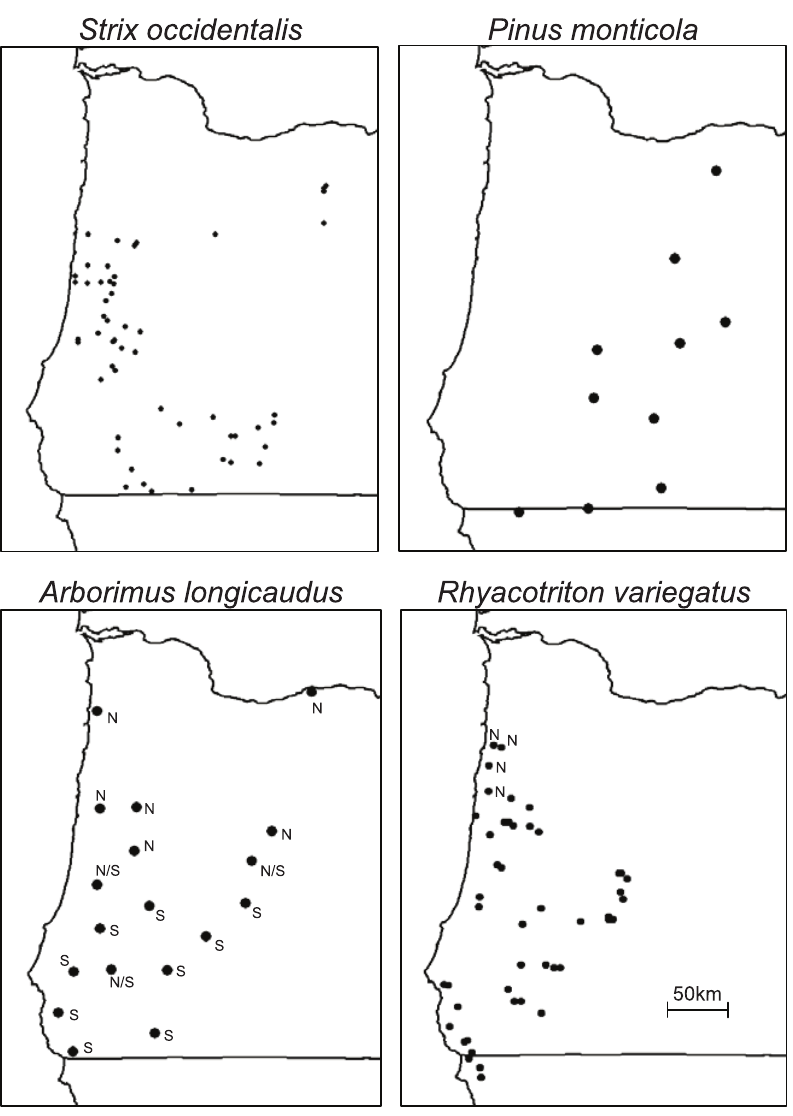
Figure 1. Maps illustrating geographical locations of individuals analyzed for this study. Note that in the case of S. occidentalis caurina and P. monticola , genetic data reflected the presence of a single phylogenetic lineage or phenetic cluster within the geographical range displayed. In contrast, previous genetic analyses of A. longicaudus and R. variegatus indicated the presence of separate ‘‘northern’’ and ‘‘southern’’ haplotype lineages in western Oregon (labeled with ‘N’ and ‘S’, respectively). For our analyses, only haplotypes corresponding to ‘‘southern’’ lineages were included in analyses of these two species (unlabeled locations on R. variegatus map and locations labeled with an ‘‘S’’ on A. longicaudus map). See text for more information.